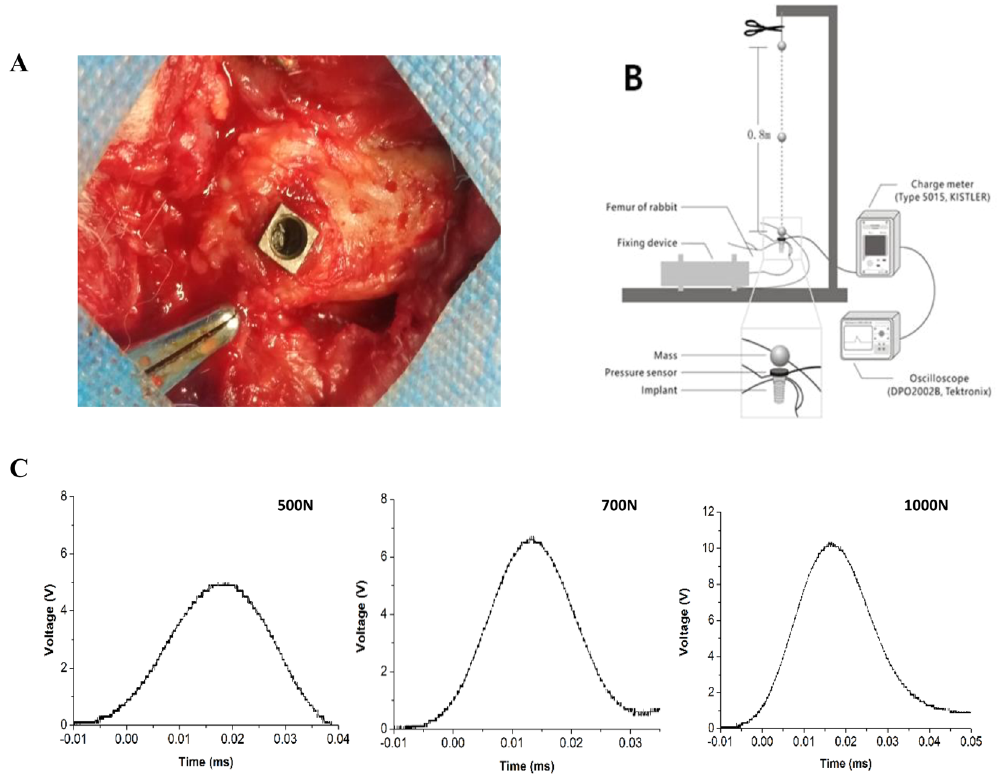
Figure 1. Implantation surgery and impact loading. ( A ) The distal femoral condyle was chosen as the site for implantation. ( B ) Schematic of impact loading. ( C ) Voltage values obtained under various rates of impact